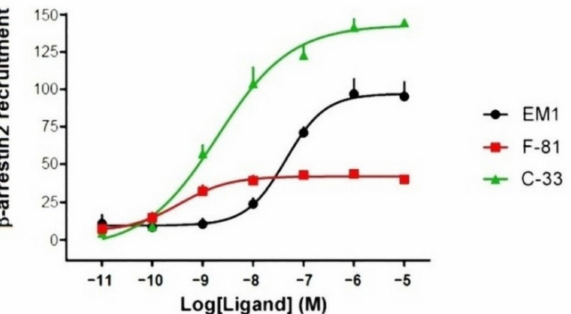
Figure 3. Ligand induced β -arrestin 2 recruitment in CHO-K1 OPRM1 β -arrestin 2 expressing cells by EM-1, C-33, and F-81. Data are normalized to the maximum stimulation caused by EM-1 (100%); values are expressed as mean ± SEM, n = 5.